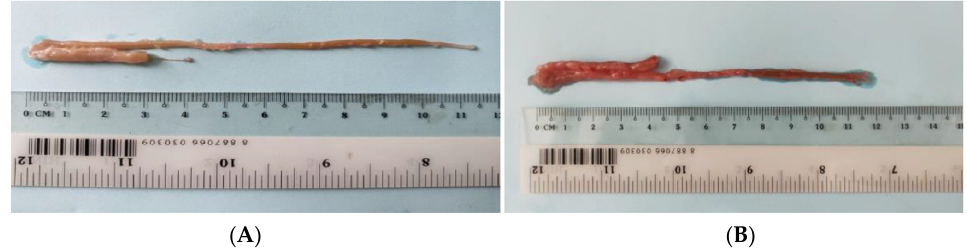
Figure 1. Intestinal anatomical structure of wild ( A ) and cultured ( B ) Hemibarbus maculatus. A large amount of fat on the gut surface of the cultured, but not wild fish, was found. Table 3. Morphological parameters of wild and cultured Hemibarbus maculatus.